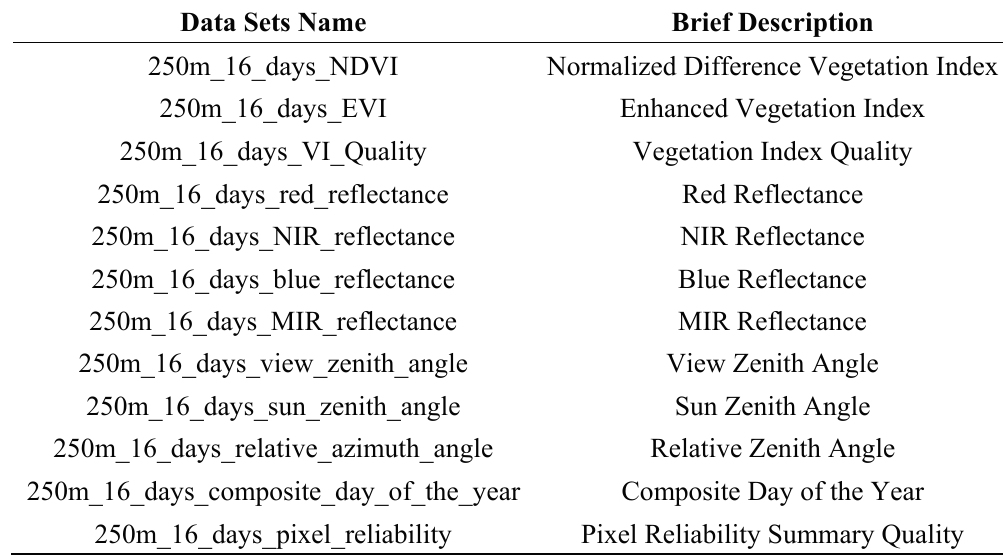
Table 1. MOD13Q1 data sets.